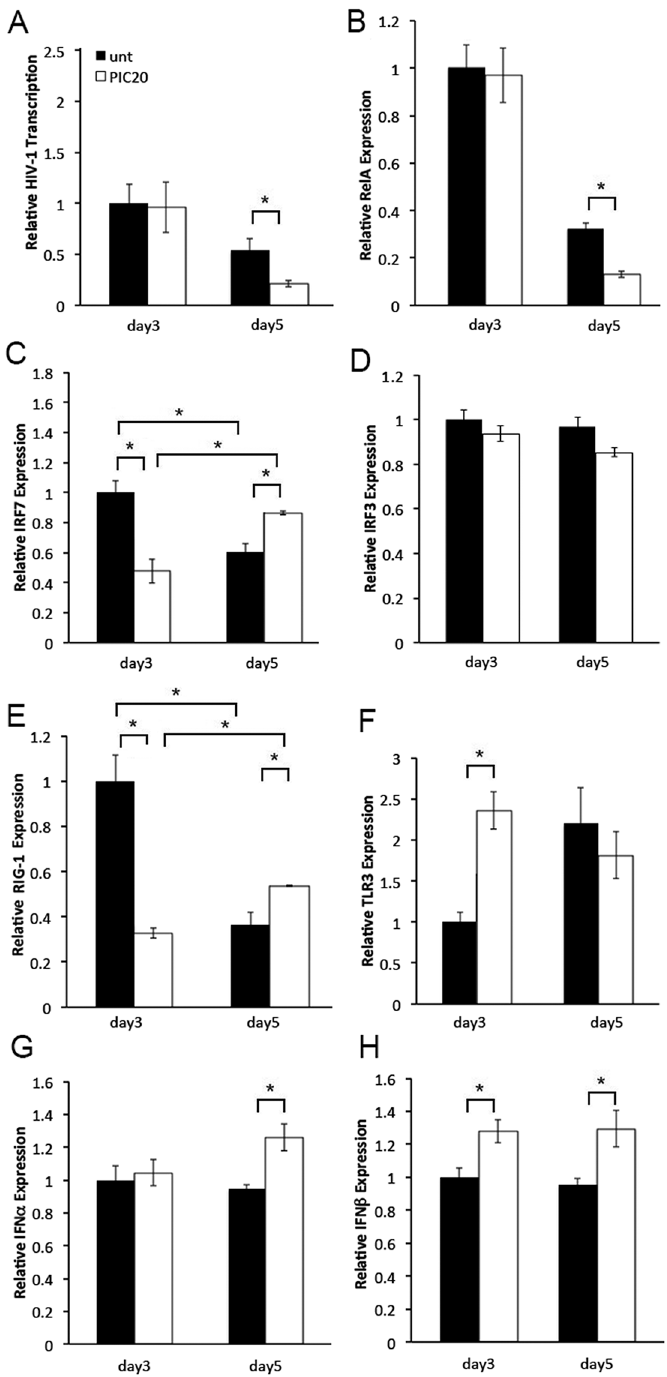
Fig 2. Poly (I:C) decreases HIV-1 transcription in cervical tissues by enhancing IRF7 mediated antiviral responses and reducing RelA expression. (A) Levels of HIV-1, (B) RelA, (C) IRF7, (D) IRF3, (E) RIG-1, (F) TLR3, (G) IFN α and (H) IFN β transcription in HIV-1-infected cervical tissues left untreated or treated with poly (I:C) at 20 μ g/ml were quantified by RT-PCR on days 3 and 5 after infection. All data was normalized to glyceraldehyde 3-phophate (GAPDH). For each gene, day 3 values in untreated control tissues were set to 1. Day 5 values in untreated control tissues or days 3 and 5 values in poly (I:C) treated tissues were normalized to 1. Results were consistent among three donors and are shown as the mean ± STDEV from one representative experiment with each condition tested in triplicate. * p < 0.05 for untreated and poly (I: C) treated